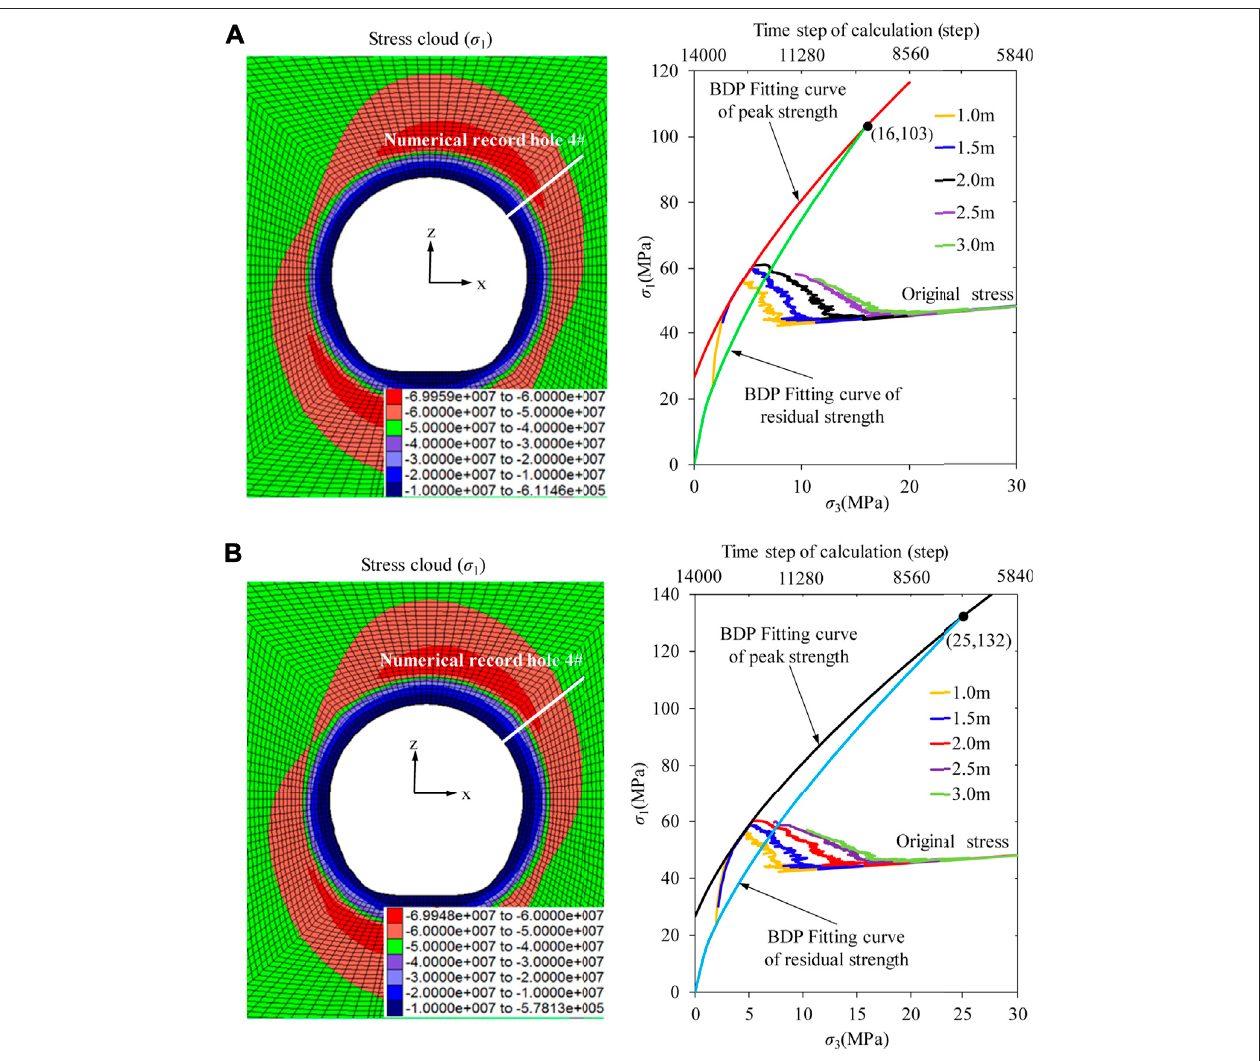
FIGURE 5 | Stress path of surrounding rock masses induced by excavation. (A) Condition one, (B) Condition two.